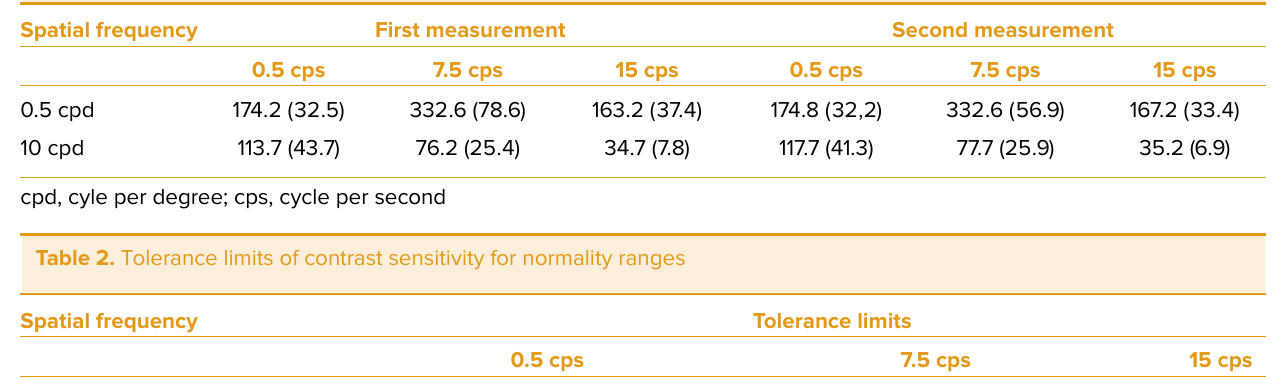
Table 1. Descriptive data from the first and second contrast sensitivity measurements